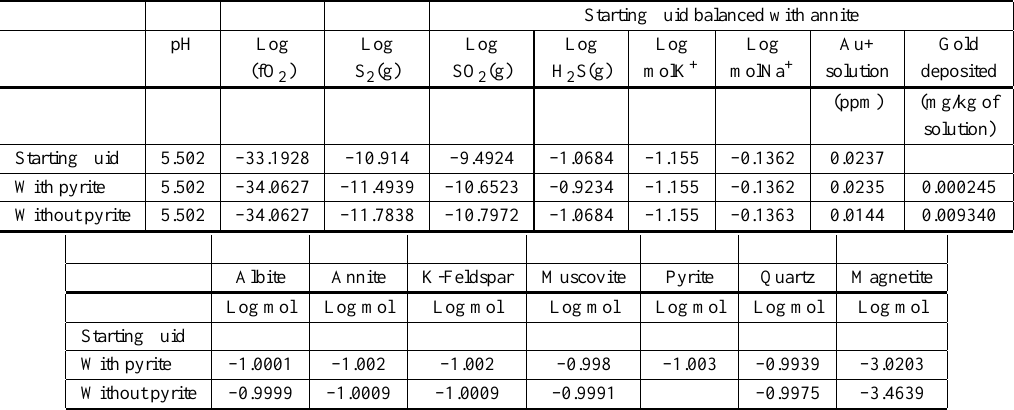
Results for the starting fluid in balance with